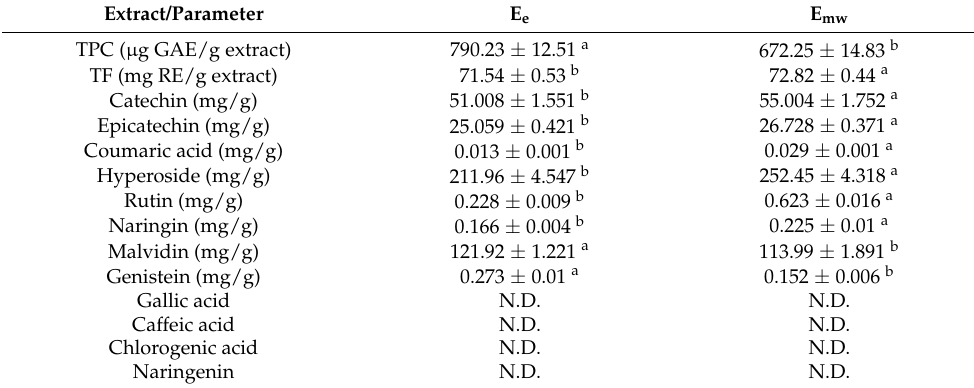
Table 2. The total content of phenolic compounds (TPC) and flavonoids (TF) in the analyzed extracts, according to the HPLC results 1